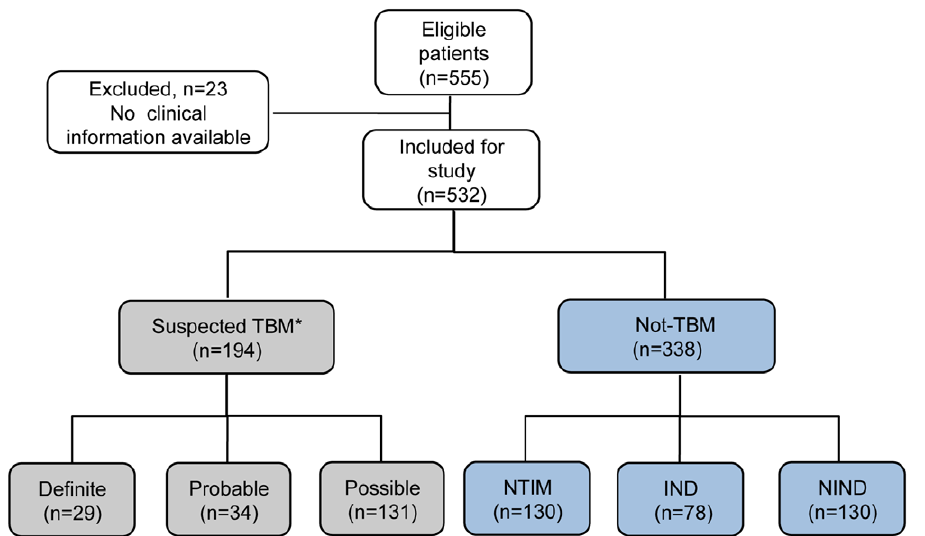
Figure 1. Categorization of CSF samples. *Suspected TBM were classified into ‘Definite’, ‘Probable’ and ‘Possible’ categories; ‘Not-TBM’ included Non Tuberculous infectious meningitis (NTIM), Infectious neurological disorders (IND) and Non-infectious neurological disorders.